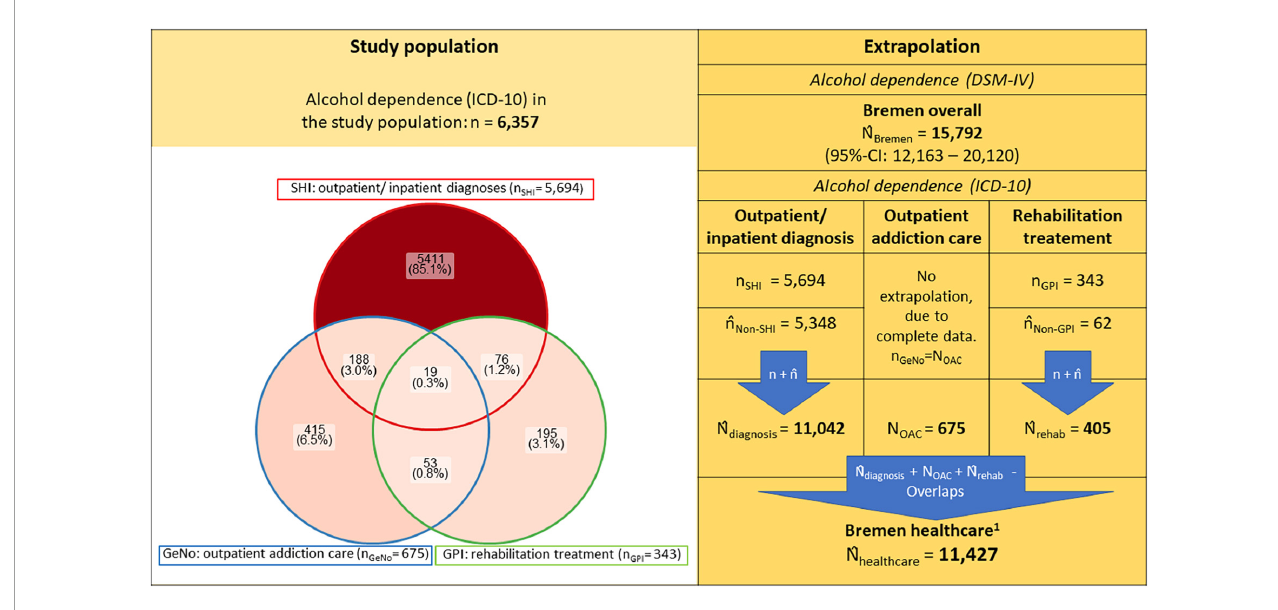
FIGURE1 Prevalence of alcohol dependence in study population and extrapolated to total population of Bremen. n / N denote each the empirical sample and population sizes, whereas ˆn / ˆN represent the estimated and extrapolated population sizes. The study population is represented as a non-proportional Venn diagram using the R package “ggVennDiagram”. For detailed extrapolations, see Supplementary Figure 2 and Supplementary Tables 2 – 5 . SHI, statutory health insurance; GeNo, Gesundheit Nord – Bremen Hospital Group; GPI, German pension insurance. 1 Estimated individuals recognized with a diagnosis of alcohol dependence International Classification of Diseases (ICD-10) or addiction specific treatment/care in the healthcare system of